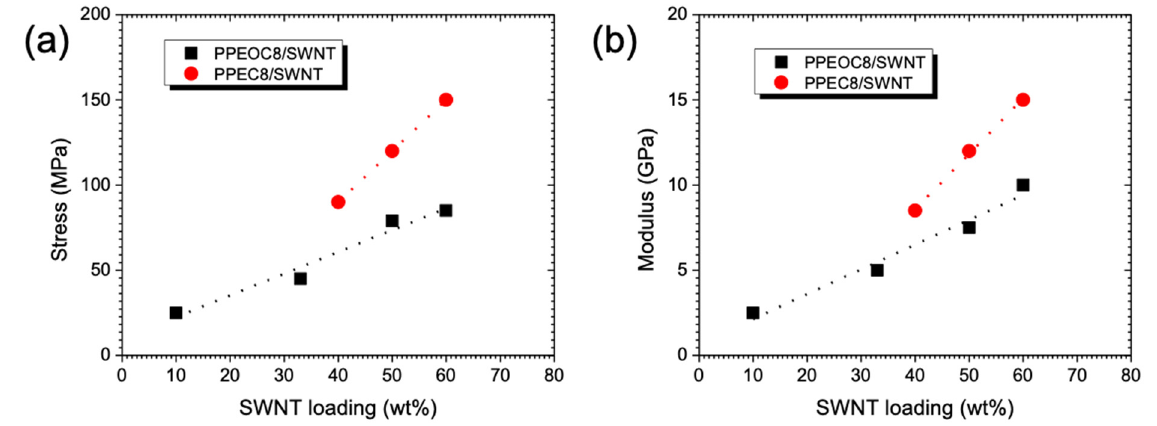
Figure 8. Mechanical properties of the PPE/SWNT nanocomposites versus SWNT loading. ( a ) Tensile stress and ( b ) Young’s modulus.